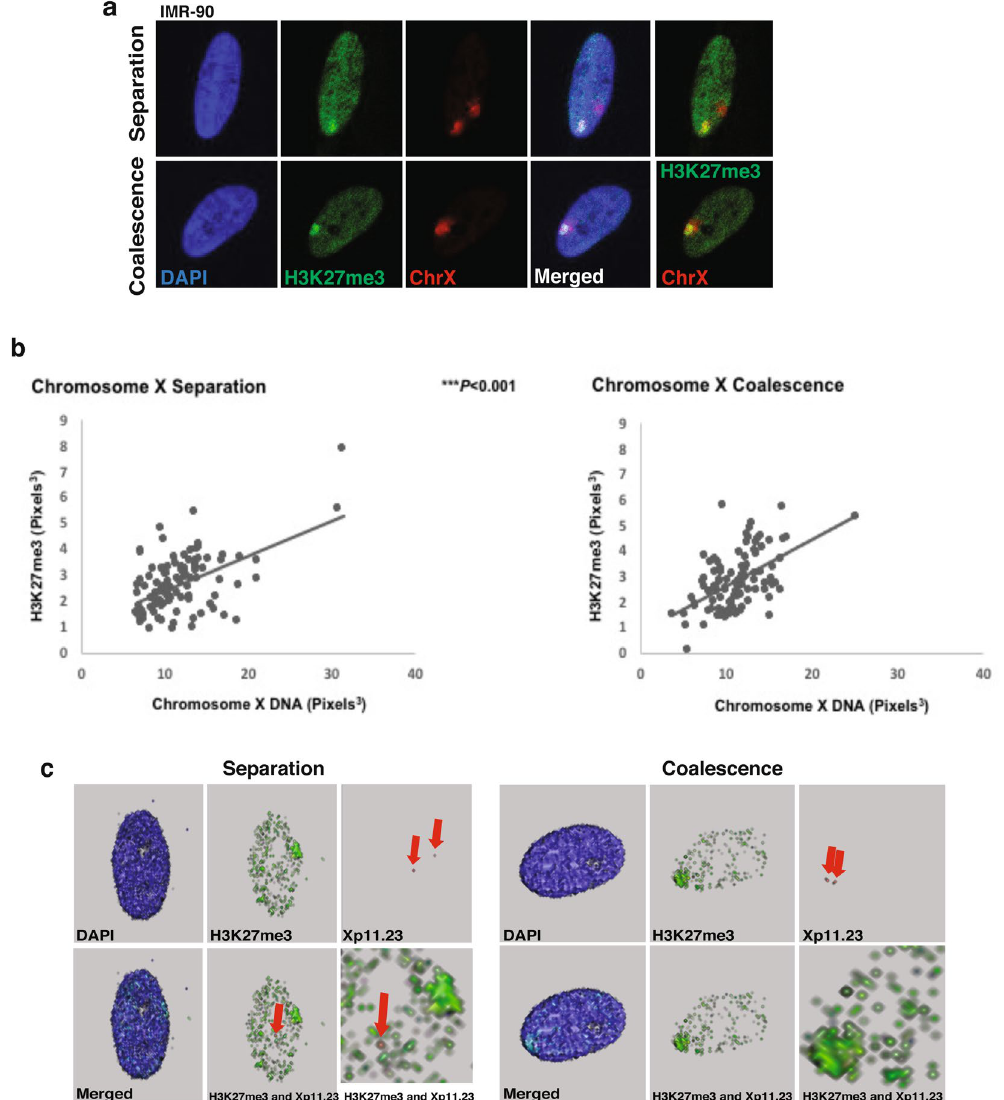
Figure 4. H3K27me3 coverage of chromosome X changes, during X coalescence in human female cells. ( a ) 3D maximum intensity projections of human IMR-90 nuclei (blue) with H3K27me3 (green) and chromosome X (red) labeled during X separation (upper panel) and coalescence (lower panel). ( b ) 3D volumetric measurements of concentrated H3K27me3 and total chromosome X, each data point represents one nucleus. A total of 100 nuclei analyzed during X separation and coalescence. * P < 0.05, ** P < 0.01, *** P < 0.001, Welch two sample t -test. ( c ) 3D renderings of IMR-90 nuclei (blue) with H3K27me3 (green) and Xp11.23 loci (red) labeled during chromosome X separation (left panel) and chromosome X coalescence (right panel). Red arrows highlight visible Xp11.23 loci. Bottom right images are magnifications of bottom center